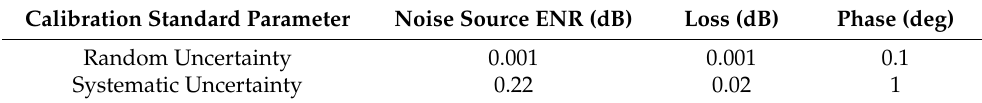
Table 2. Estimated uncertainties for various parameters of the calibration